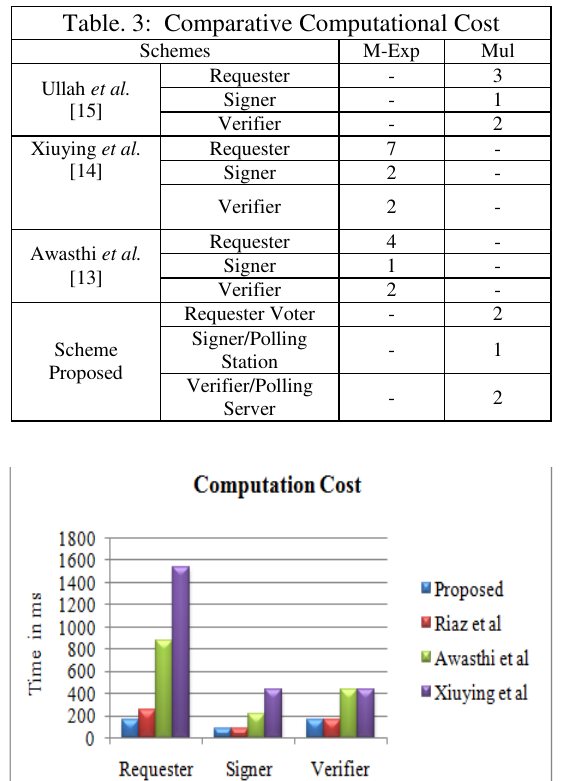
Fig. 4: Computational Time comparison on each node